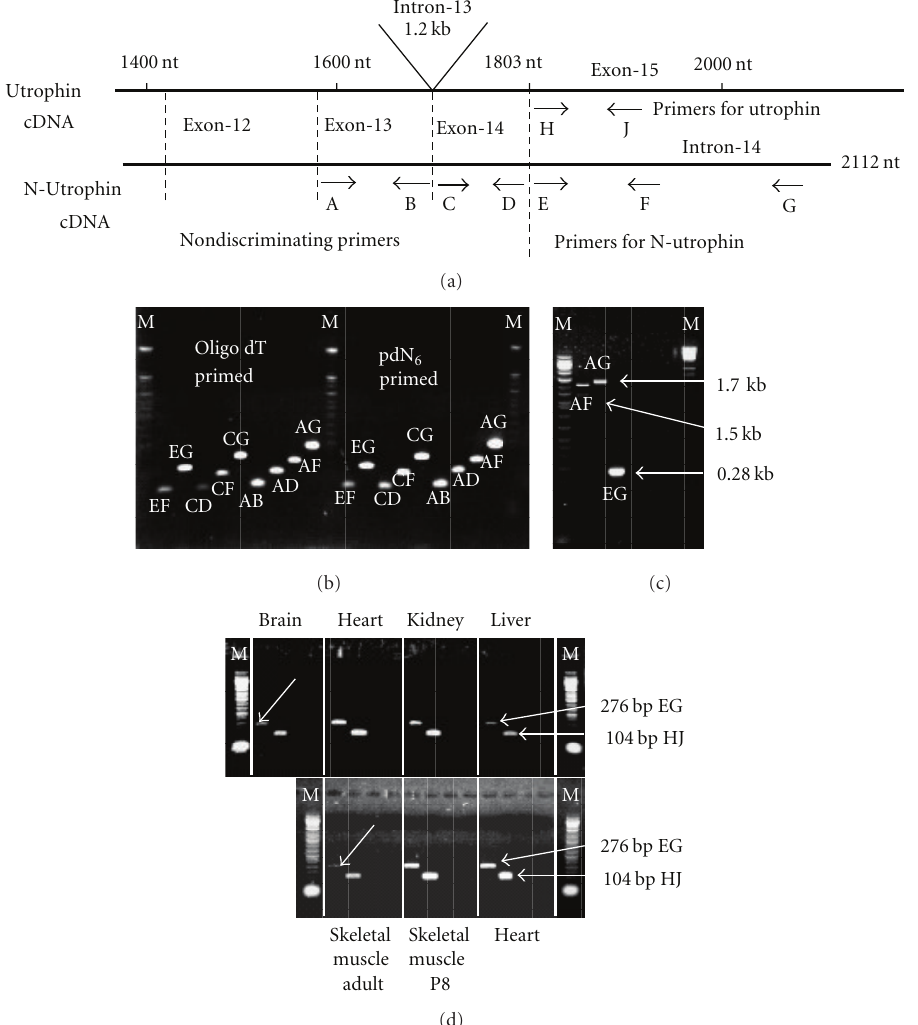
Figure 2: Detection of the mRNA for the N-utrophin isoform and for full-length Up395 in rat tissues by RT-PCR and electrophoresis in 1% agarose with ethidium bromide. (a) Organisation of mRNA for full-length utrophin (upper line) and for N-utrophin (lower line) with direction of primers (lettered arrows) and exon borders (dashed lines). Sequence homolgy breaks down at nucleotide (nt) 1803. Non- discriminating primers (A, B, C, D) recognise both isoforms, while primers (E, F, G) are specific for N-utrophin, and primers (H, J) are specific for full-length utrophin. The genomic DNA contains intron-13 of 1.2 kilobases (kb) between exon-13 and 14. Exon numbering is in homology to that of dystrophin. (b) RT-PCR (40 cycles) products ranging in size from 100 to 500 base pairs (bp) from poly(A) + RNA of rat kidney primed with either oligo(dT) or pd(N)6. (c) RT-PCR (40 cycles) products (AF and AG) from genomic rat liver DNA display sizes of 1.5 and 1.7 kb containing intron-13 which adds 1.2 kb to each fragment. Product (EG) of 0.28kb is specific for N-utrophin as control. The three black lanes between EG and the markers (M) are controls with the same primer pairs but without DNA. (d) RT-PCR (30 cycles) products (EG specific for N-utrophin and HJ specific for full-length utrophin) in di ff erent tissues. Black lanes are negative controls without reverse transcriptase. Note the larger amount of N-utrophin message in skeletal muscle of young rats (postnatal day 8) as compared to adult (arrow). Pairs of letters denote primer pairs; M stands for DNA